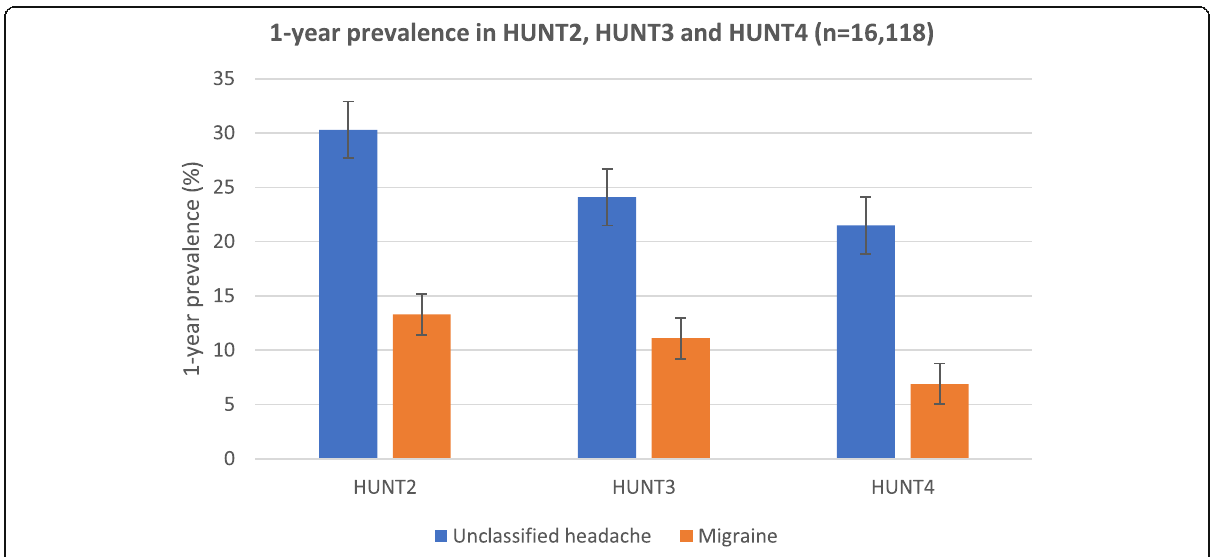
Fig. 2 Development of migraine and headache prevalence among those who participated in HUNT2, HUNT3, and HUNT4 (n =